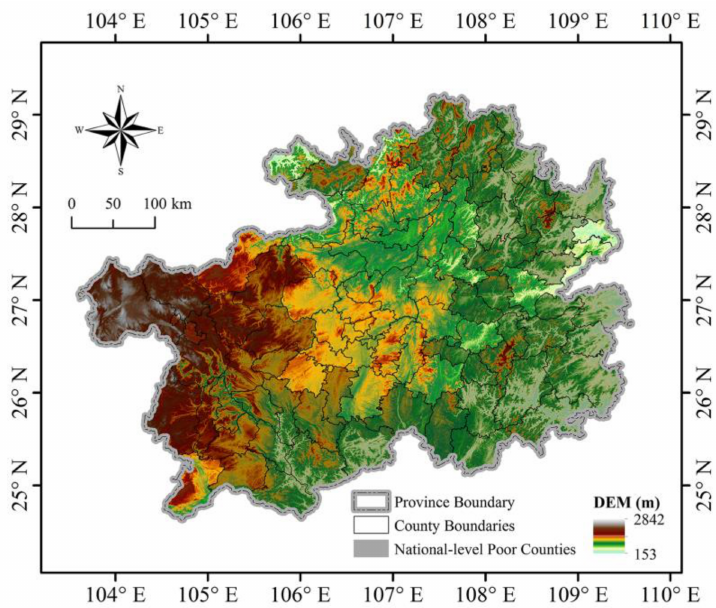
Figure 1. Distribution of the national-level poor counties of Guizhou in